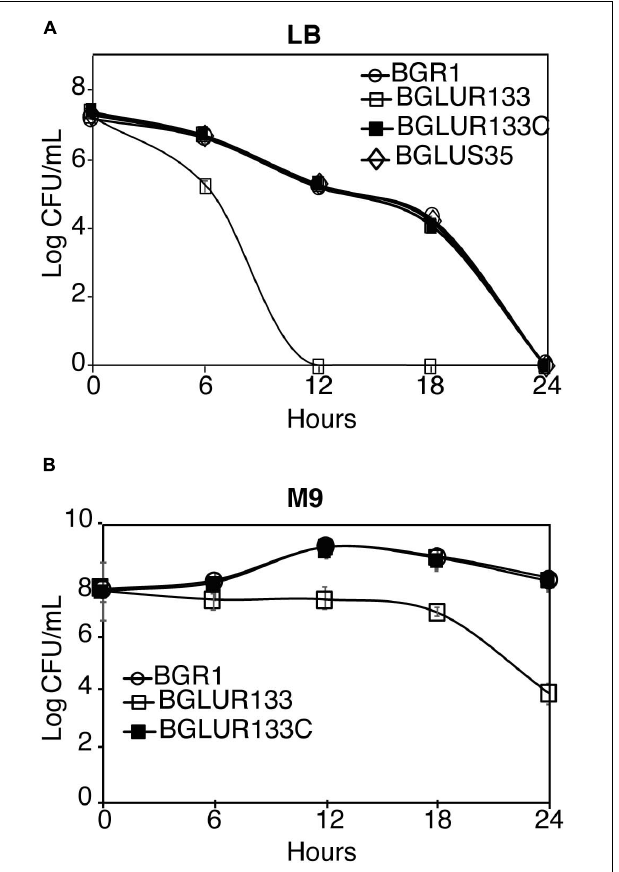
FIGURE 7 | Exponential population decline at 42 ◦ C as a result of mutations in GluR. At 6-h intervals, the indicated strains’ population densities in Lysogeny Broth (LB) medium (A) and M9 medium (B) were quantified by colony-forming unit (CFU) counting, and the results are expressed as log CFU/ml. Data are means ± standard error (SE) of